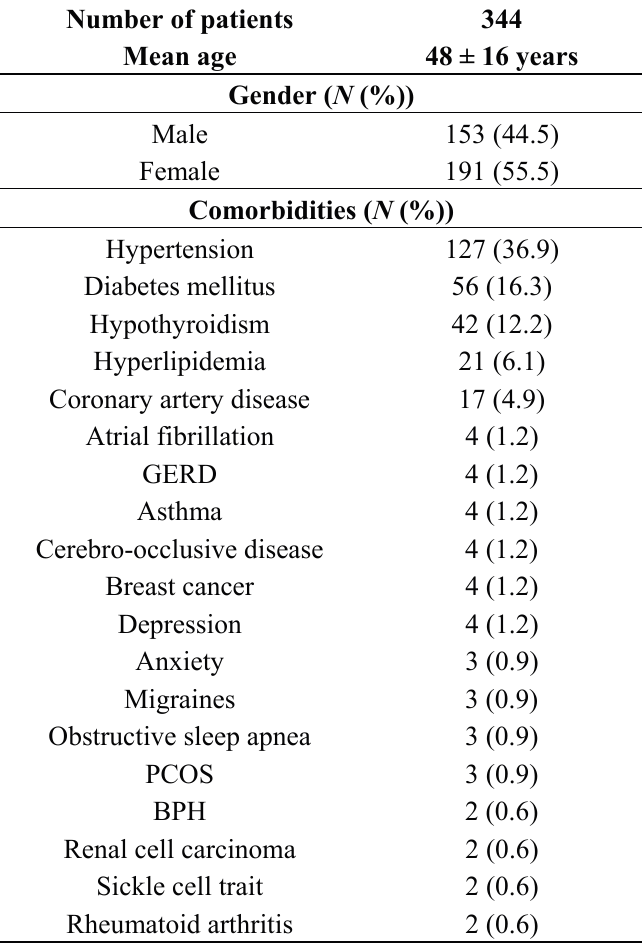
Table 1. Age, sex and comorbidities of 344 consecutive patients who underwent transsphenoidal resection of a pituitary mass at the authors’ institution between January, 2006, and December, 2012. GERD = gastroesophageal reflux disease; PCOS = polycystic ovary syndrome; BPH = benign prostatic